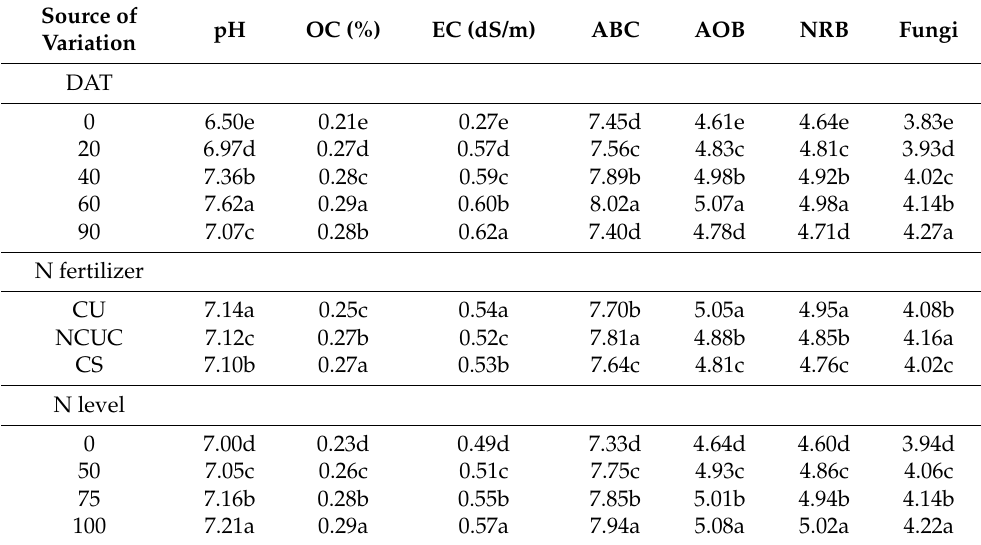
Table 1. Effect of different types of fertilizer on soil chemical properties and microbial viable cell counts (log cfu g − 1 soil) during potato cultivation.